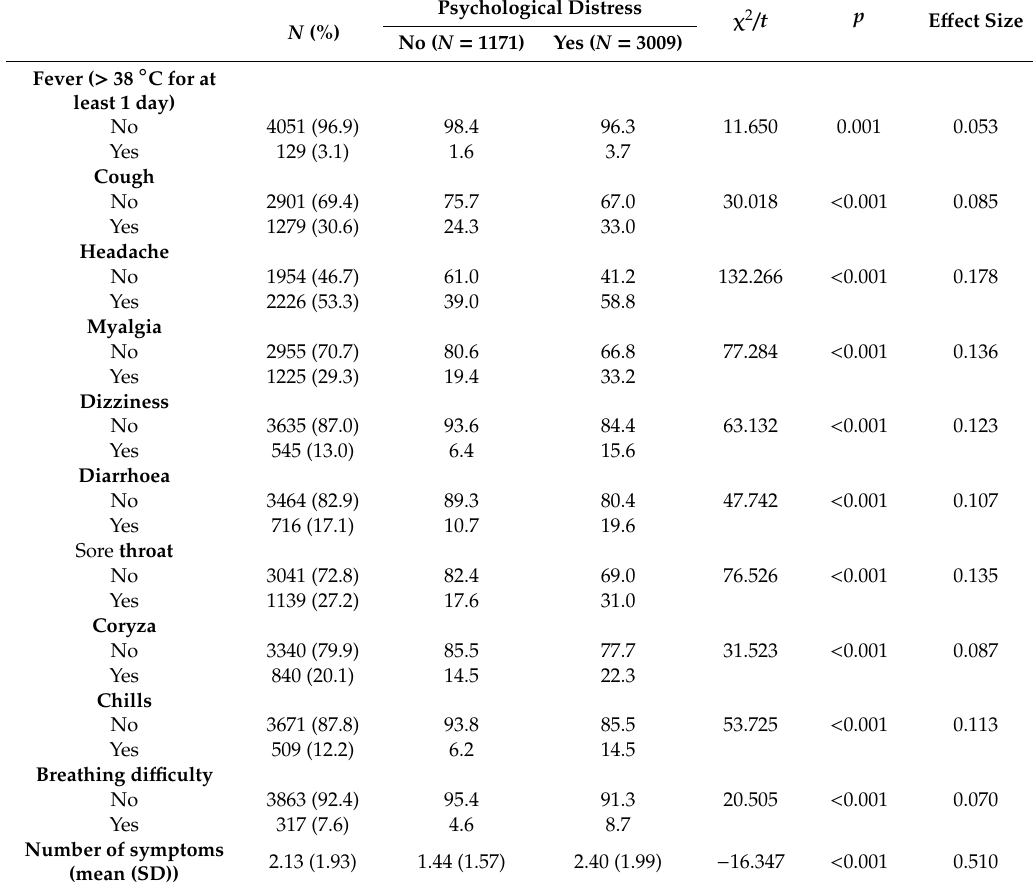
Table 3. Association between physical symptoms in the past 14 days and psychological distress during the COVID-19 pandemic (N = 4180). Psychological Distress χ 2 / t p E ff ect Size N (%) No ( N = 1171) Yes ( N = 3009) Fever ( > 38 ◦ C for